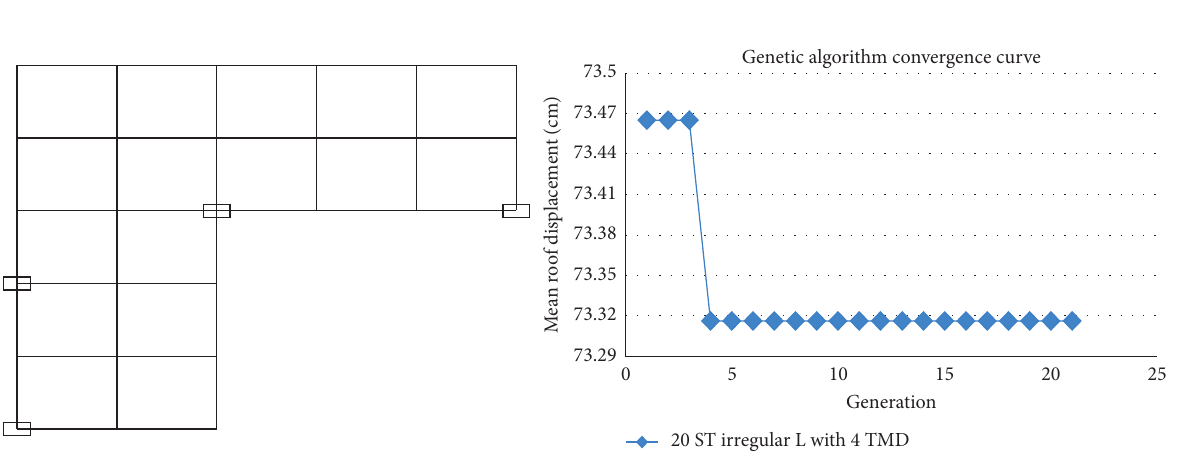
Figure 29: Convergence diagram of the twenty-story irregular L-shaped model with 4 dampers in genetic algorithm (right) and damper optimal positions (left).